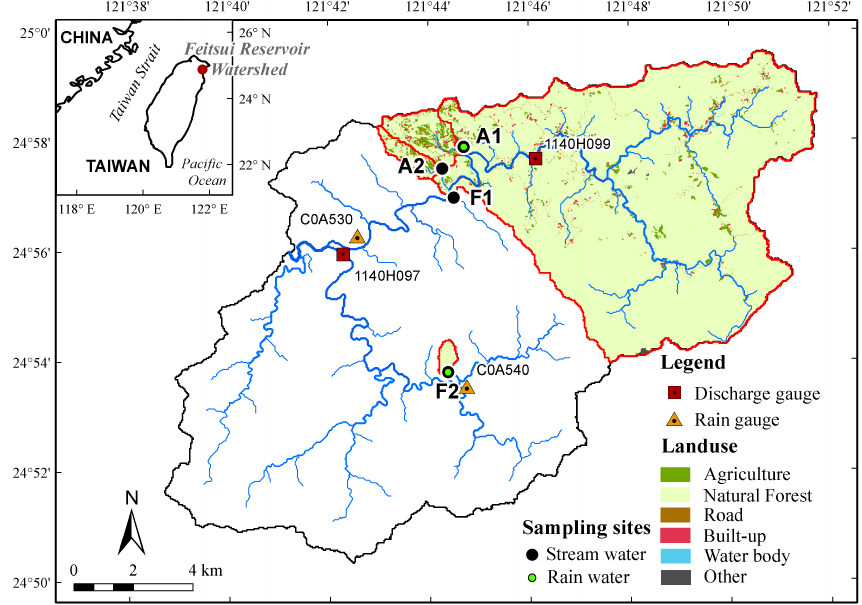
Figure 1. Location and land use distribution of the studied watersheds.